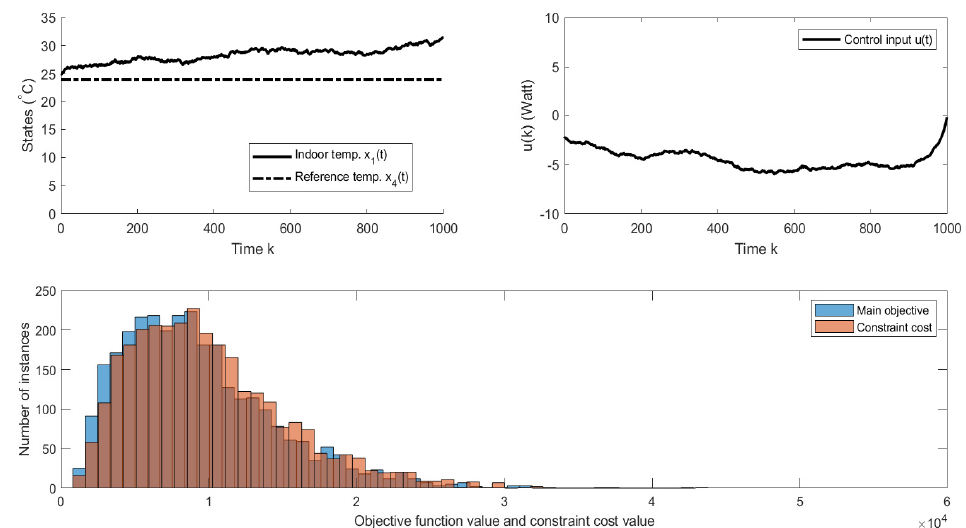
Figure 3. With γ = 10,000, the top figures show evolution of the indoor temperature x 1 ( t ) , reference temperature x 4 ( t ) , and the input u ( t ) . The bottom figure depicts the histograms of the objective function and constraint cost.